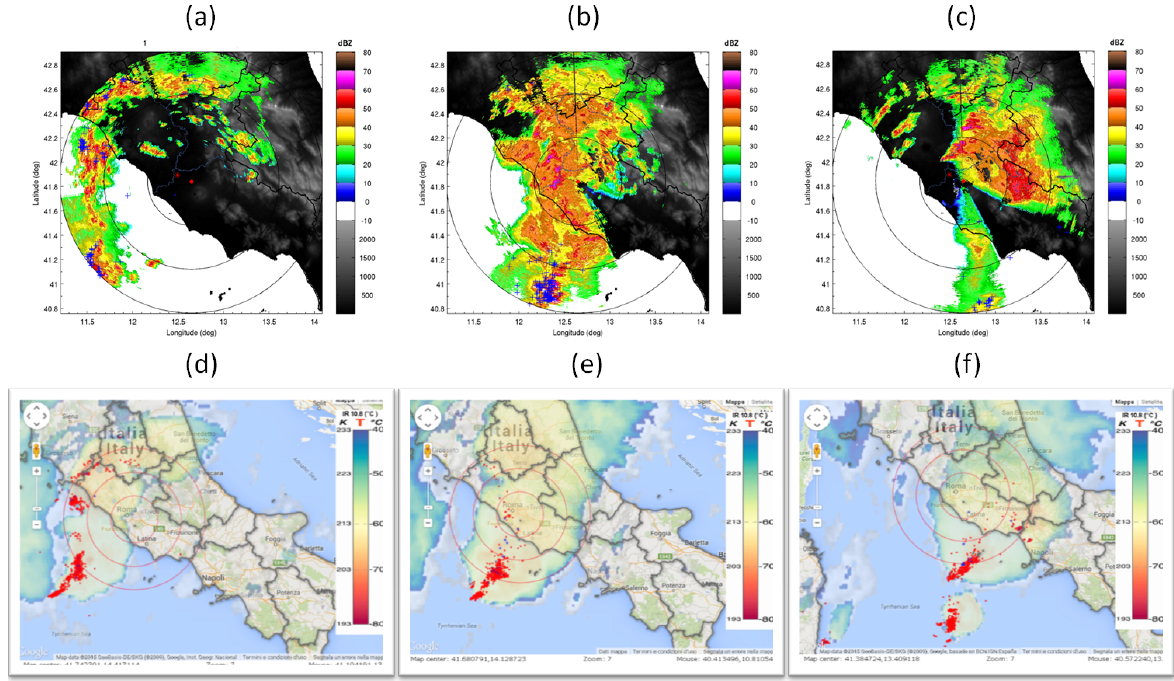
Figure 4. As in Fig. 3 for 12 October 2012 at 03:00UTC (a, d) , 04:30UTC (b, e) , and 06:00UTC (c, f) .